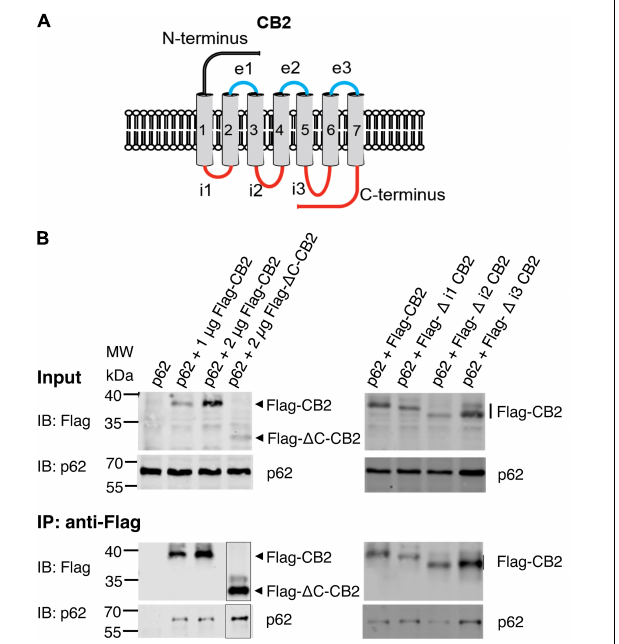
FIGURE 5 | (A) Schematic drawing of CB2 receptor protein with extracellular N-terminus and three extracellular loops (e1, e2, e3), seven transmembrane domains, and three intracellularly localized loops (i1, i2, i3) and the C-terminus. The red marked intracellular regions were deleted in CB2 expression plasmids and used for following Co-IP studies. (B) Representative Western blot results of CB2 precipitations using Flag antibody with lysates of HEK293 cells transiently transfected with p62-WT (1 µ g) and Flag-CB2 constructs with the respective deletions ( (cid:49) C-CB2, (cid:49) i1-CB2, (cid:49) i2-CB2, (cid:49) i3-CB2). Considering lower expression levels of deletion constructs compared to WT-full length Flag-CB2, the co-precipitated p62 protein levels were similar in all approaches. The IP figure was grouped from cropped parts of the same gels/blots indicated by the border line. This experiment has been performed at least two times